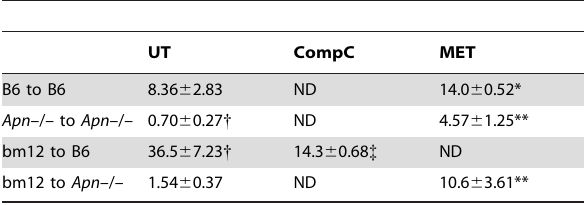
Table 2. Serum levels of IL-4 at 7 days post-operatively in mice following skin